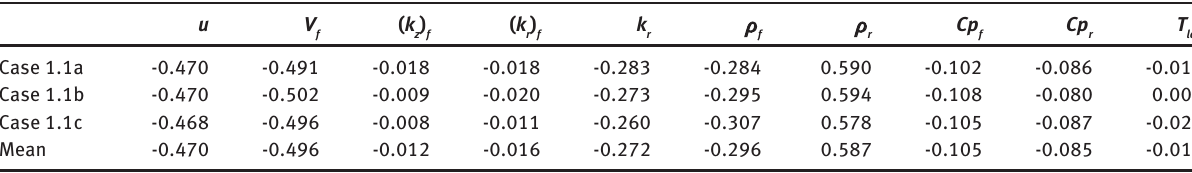
Table 3 Mean values of the correlation coefficients between the RIPs and the random output parameter (CDOCE) for 10 runs based on each MCS options in case 1.1.